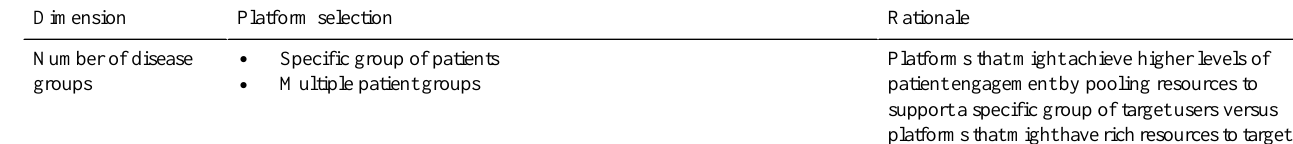
Platforms that might achieve higher levels of